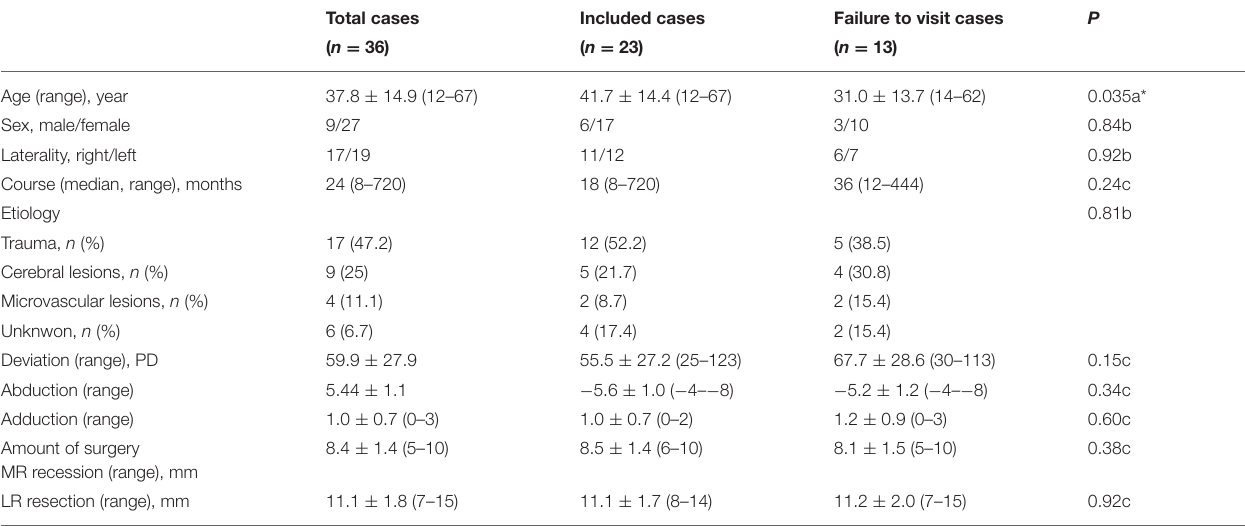
TABLE 2 | General demographic and clincial features of patients with sixth nerve